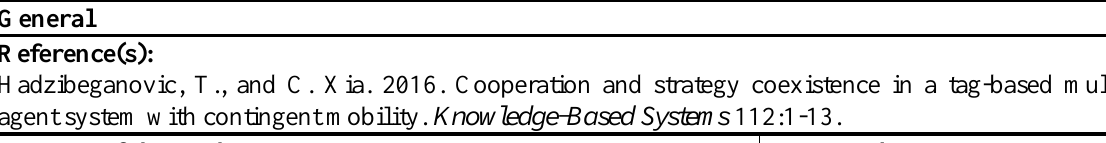
Table A1.2 Standardized protocol for the ABM described by Hadzibeganovic & Xia